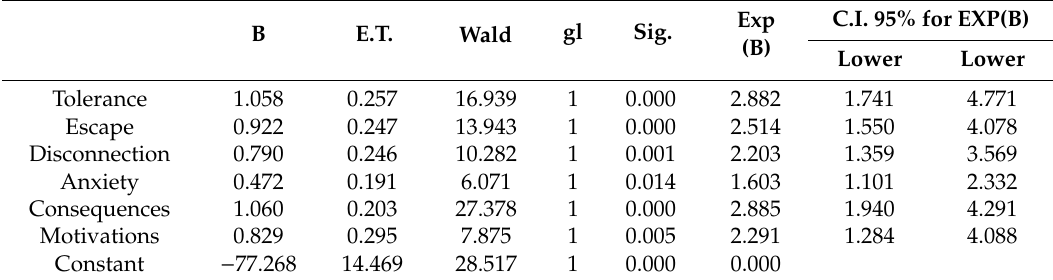
Table 11. Binary logistic regression of the self-perception on the problematic smartphone use a of university students between 24 to 26 years of age with respect to the